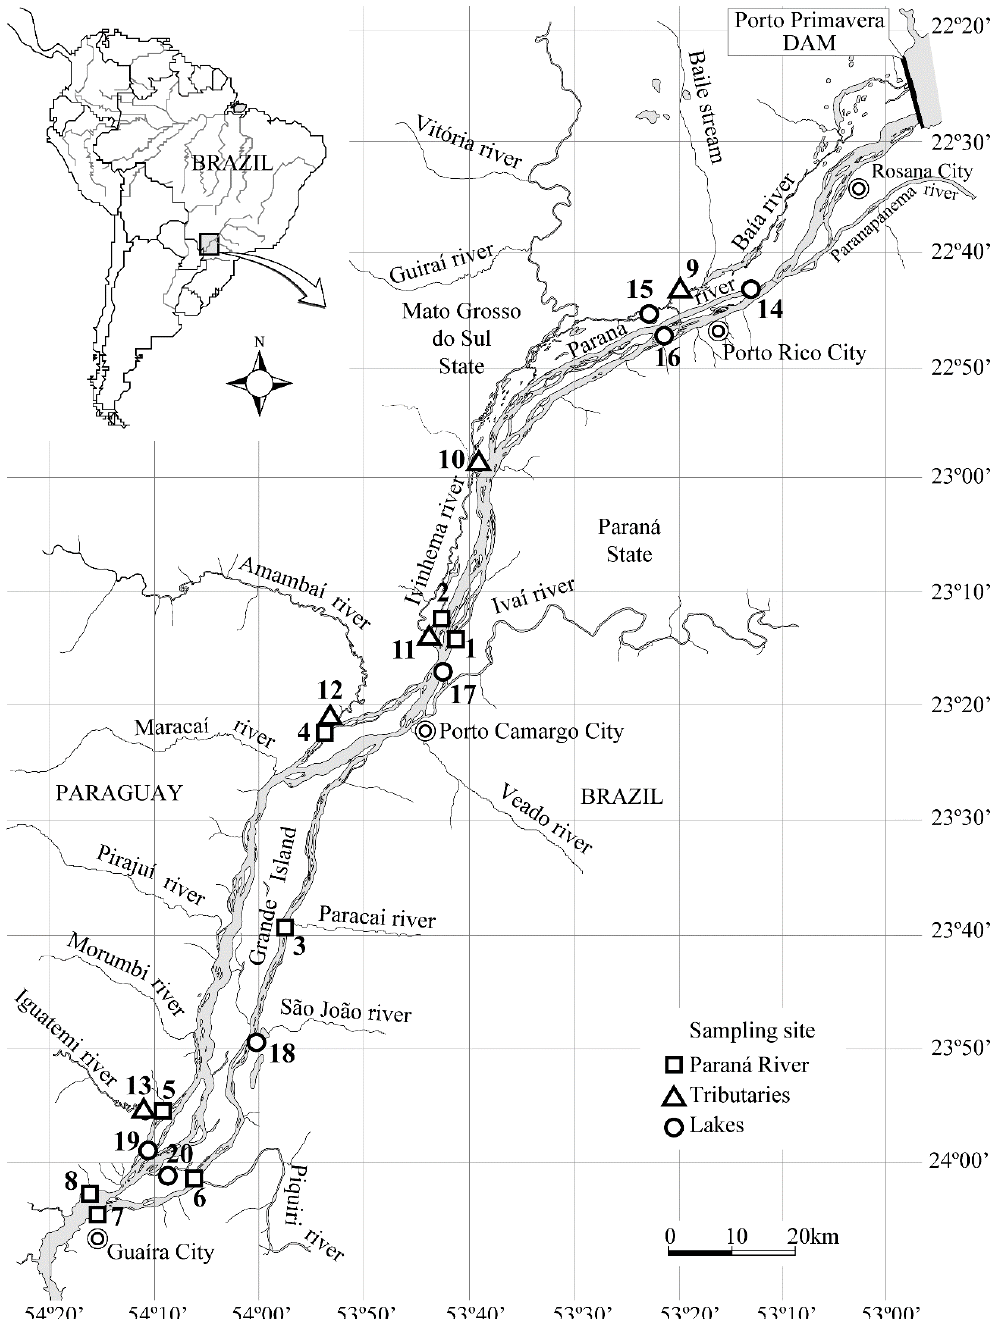
Figure 1. Sampling sites in the Paraná River (1-8), tributaries (9-13) and lakes (14-20) in the river-floodplain system of the Upper Paraná River. Locality codes are the same as shown in Table